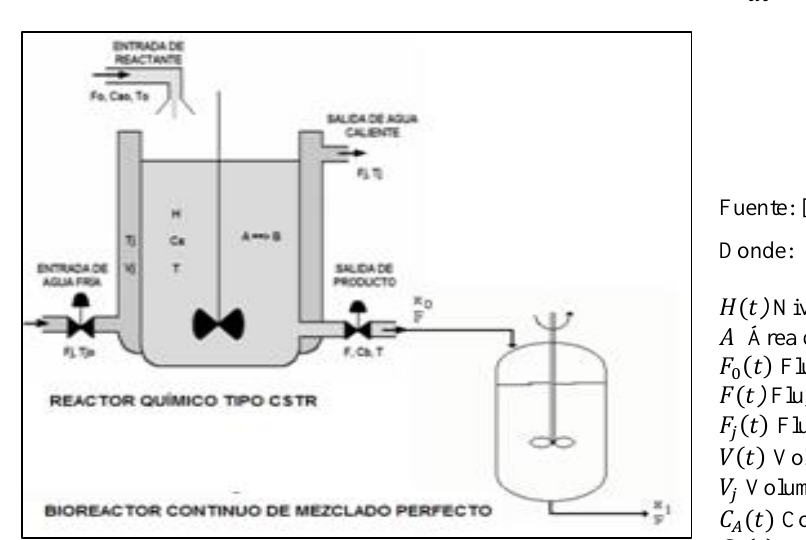
Figura 6: Planta de procesamiento químico de producción de